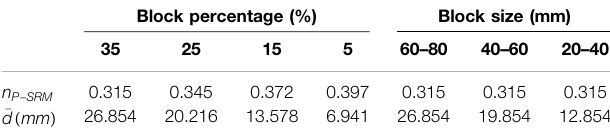
TABLE 2 | n P − SRM of phyllite bimrock